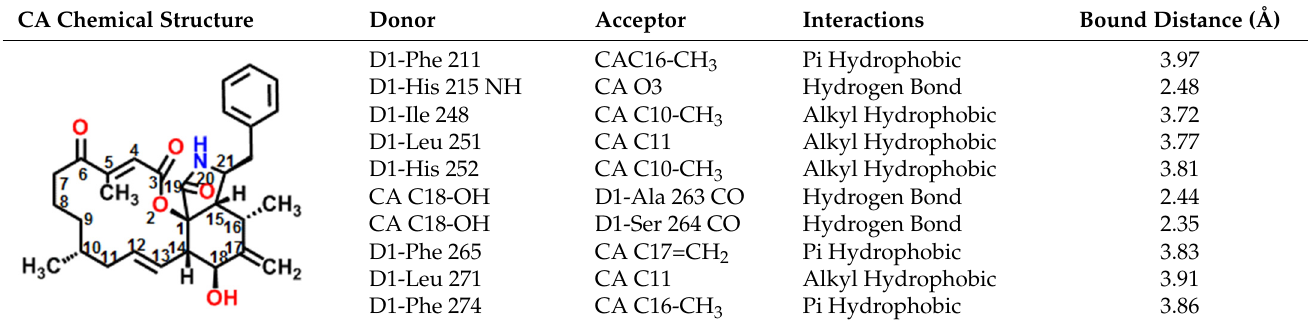
Table 2. Possible bonding interactions for CA binding to the D1 protein of A. adenophora .